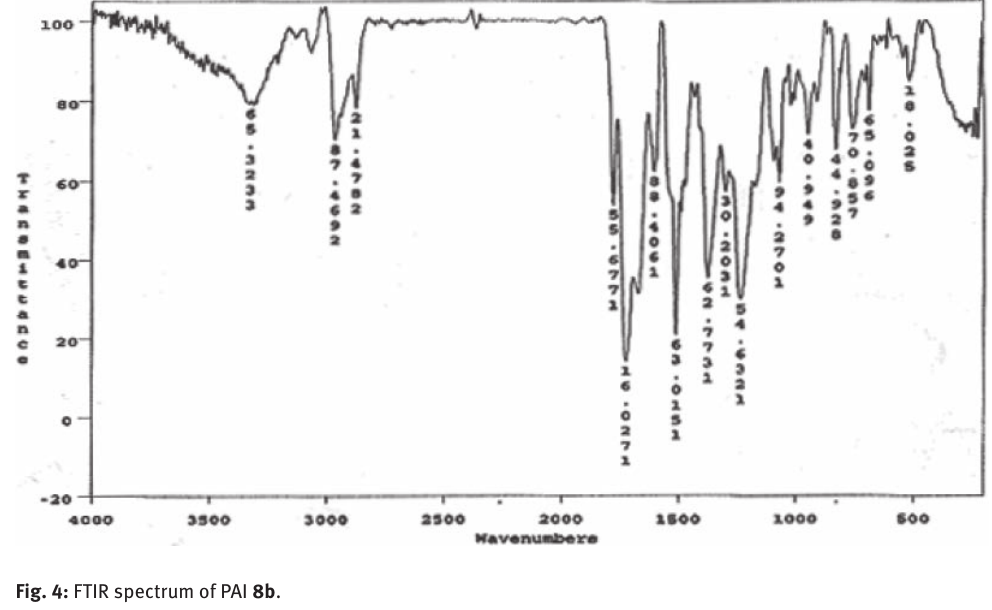
Fig. 4: FTIR spectrum of PAI 8b .